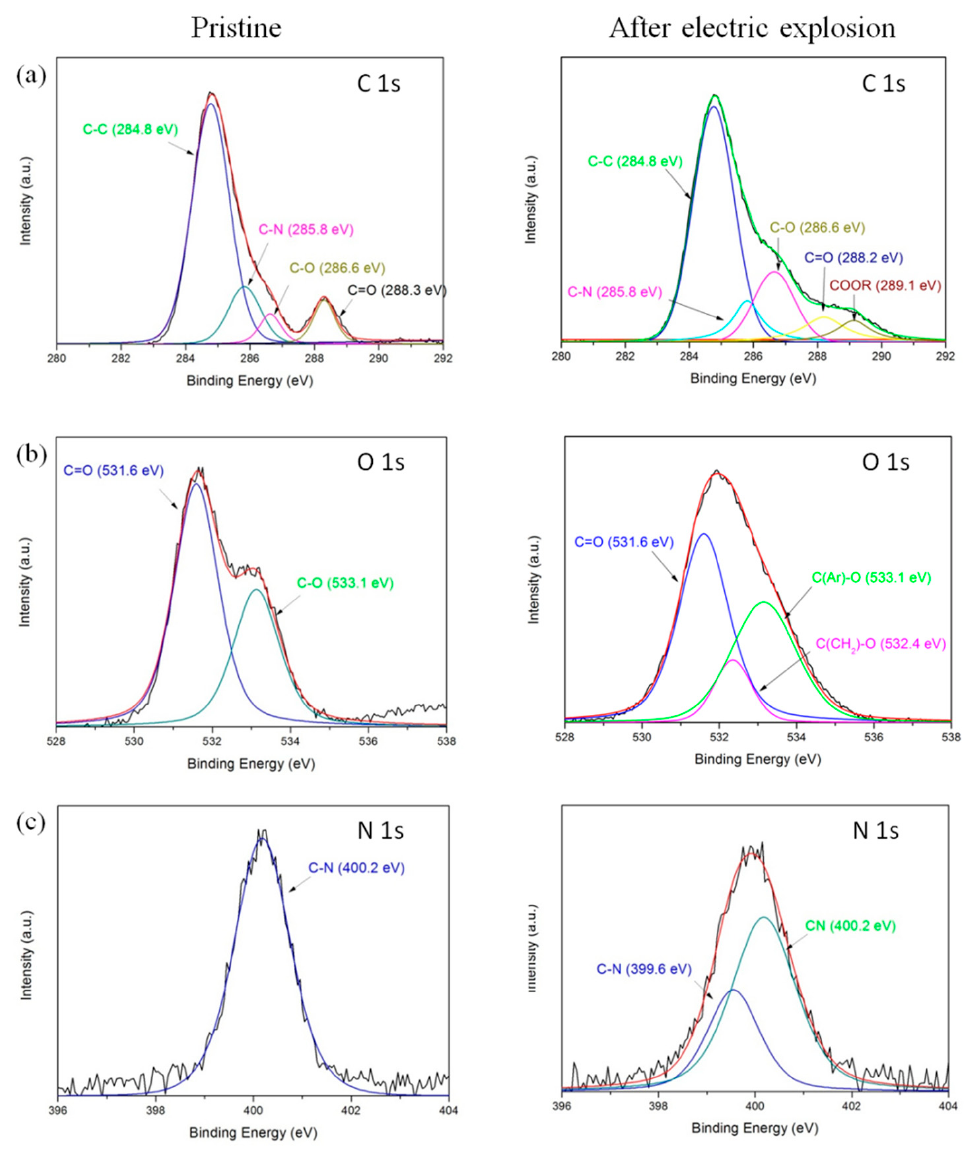
Figure 9. Curve-fitted XPS spectra of ( a ) C1s, ( b ) O1s and ( c ) N1s for pristine polyimide film and sample after the electric explosion test. Table 4. The component ratios of pristine and the sample after the electric explosion test.